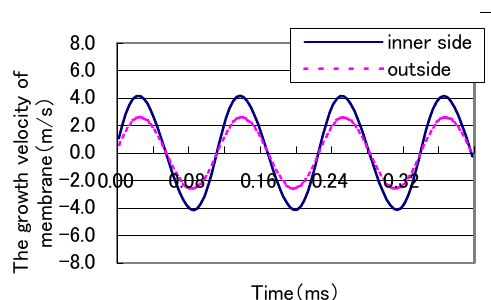
Fig. 12 Variation of growth velocity of membrane (injection pressure=0.05MPa, initial inner radius =0.75mm)